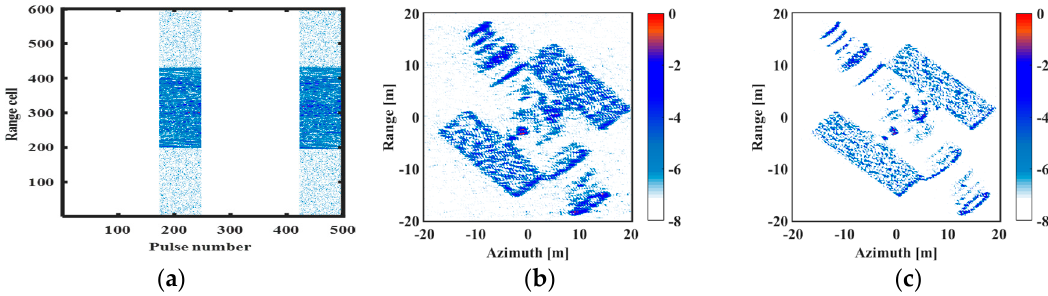
Figure 16. Range profiles and imaging results with GMS of 150 pulses: ( a ) Range profiles; ( b ) Imaging result of algorithm in [23]; ( c ) Imaging result of the proposed